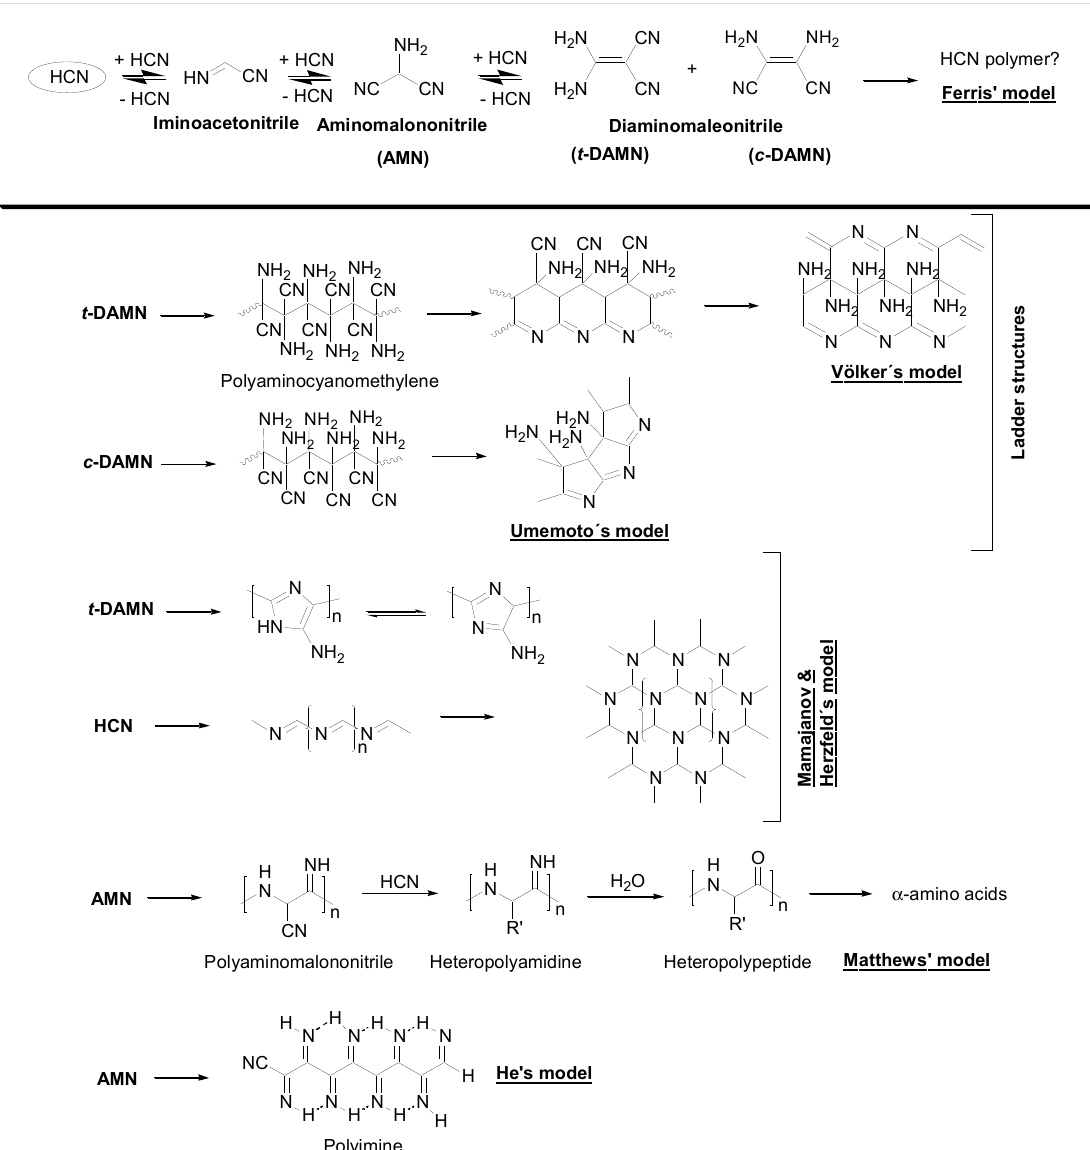
Scheme 2. Traditional proposed models for explaining the structures of HCN-derived polymers.